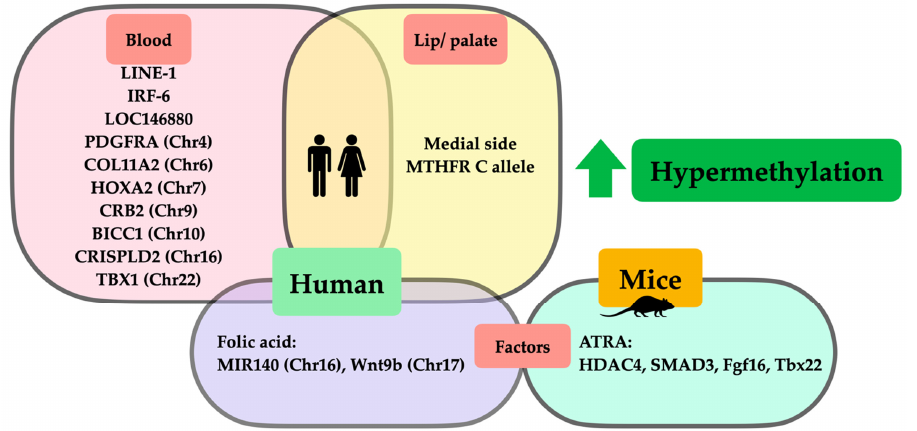
Figure 2. Schematic representation of DNA hypermethylation in orofacial clefts from animal and clinical studies. Hypermethylation from clinical studies demonstrated that (1) hypermethylated genes and chromosomes in human blood (pink square) were LINE-1, IRF-6, LOC146880, PDGFRA(Chr4), COL11A2(Chr6), HOXA2(Chr7), CRB2(Chr9), BICC1(Chr10), CRISPLD2(Chr16), and TBX1(Chr22); (2) hypermethylated genes and chromosomes in lip/palatal tissues (yellow square) were medial side of lip tissues, MTHFR C allele; and (3) factors affecting DNA hypermethylation in clinical studies (purple square) were folic acid affecting hypermethylation of MIR140(Chr16) and Wnt9b(Chr17). Regarding hypermethylation in animal studies, factors affecting DNA hypermethylation in studies on mice (green circle) included ATRA affecting hypermethylation of HDAC4, SMAD3, Fgf16, and Tbx22.